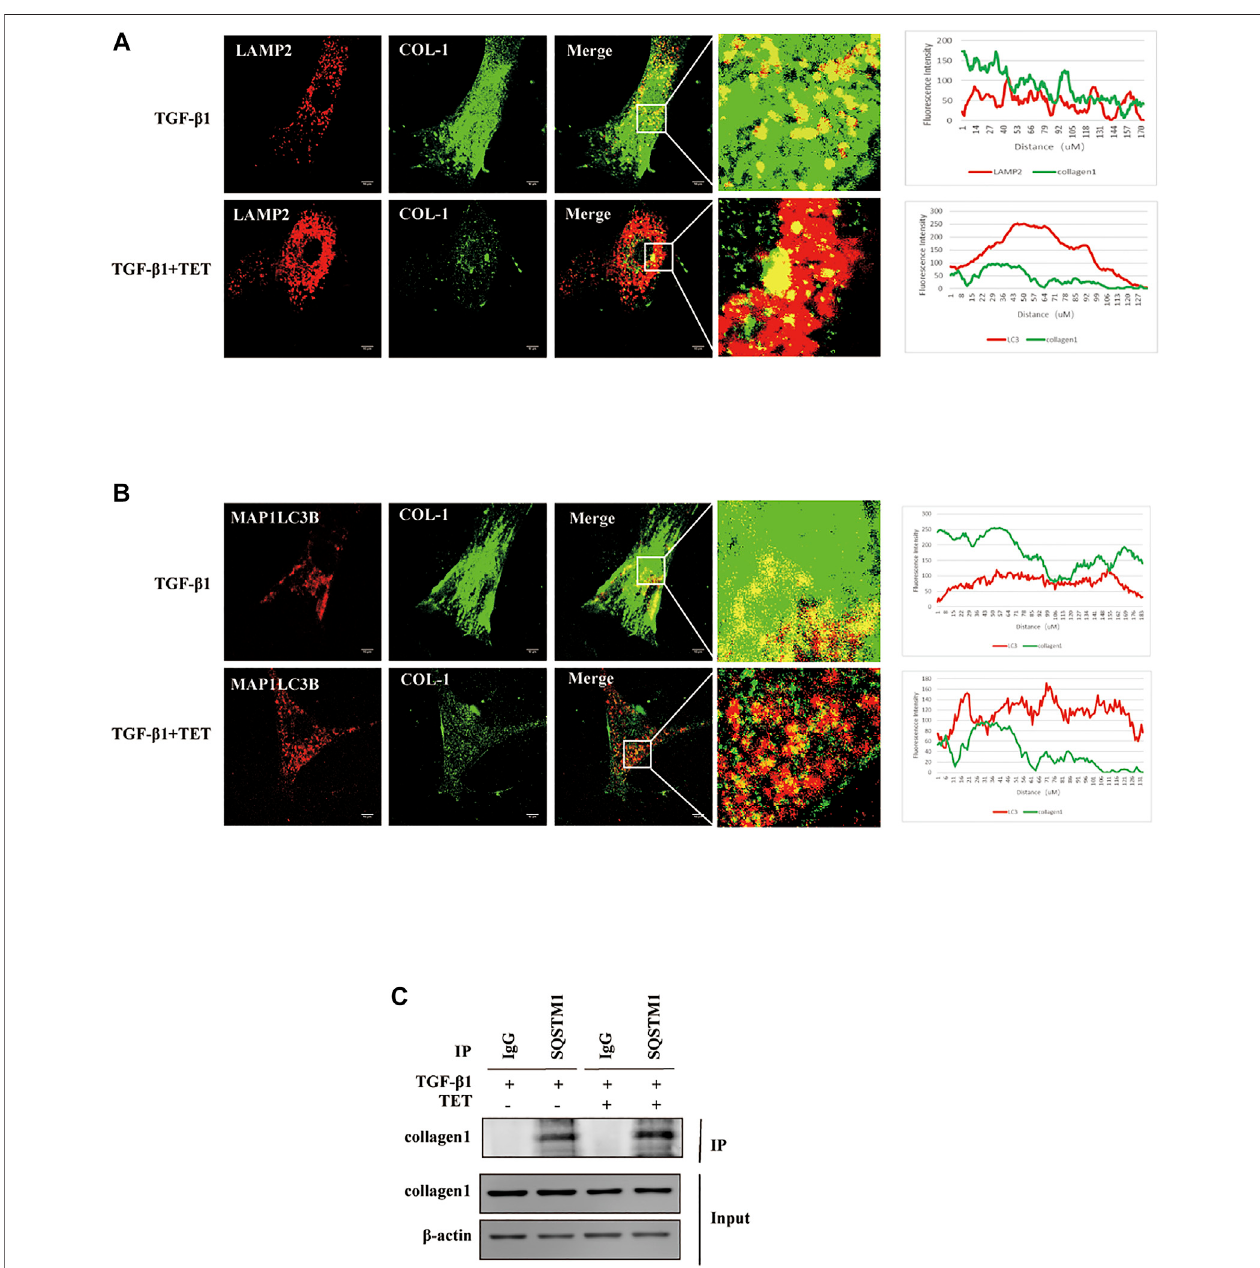
FIGURE8| Col-Iisdegradedbyautophagy.PrimaryMLFstreatedwith DMSOor TET for1 h andthen subsequently simulatedwithTGF- β 1foranadditional 24 h. (A) Confocal microscopy analysis of colocalization of LAMP2 (lysosomal markers, red) and COL-I (green). The representative single optical sections and merge images are shown. Scale bar: 10 μ m. (B) Confocal microscopy analysis of colocalization of MAP1LC3B (red) and COL-I (green). The representative single optical sections and merge images are shown. Scale bar: 10 μ M. (C) Co-immunoprecipitation (Co-IP) assays with SQSTM1 and COL-I. Samples before (Input) and after (IP) immunopuri fi cation were analyzed by